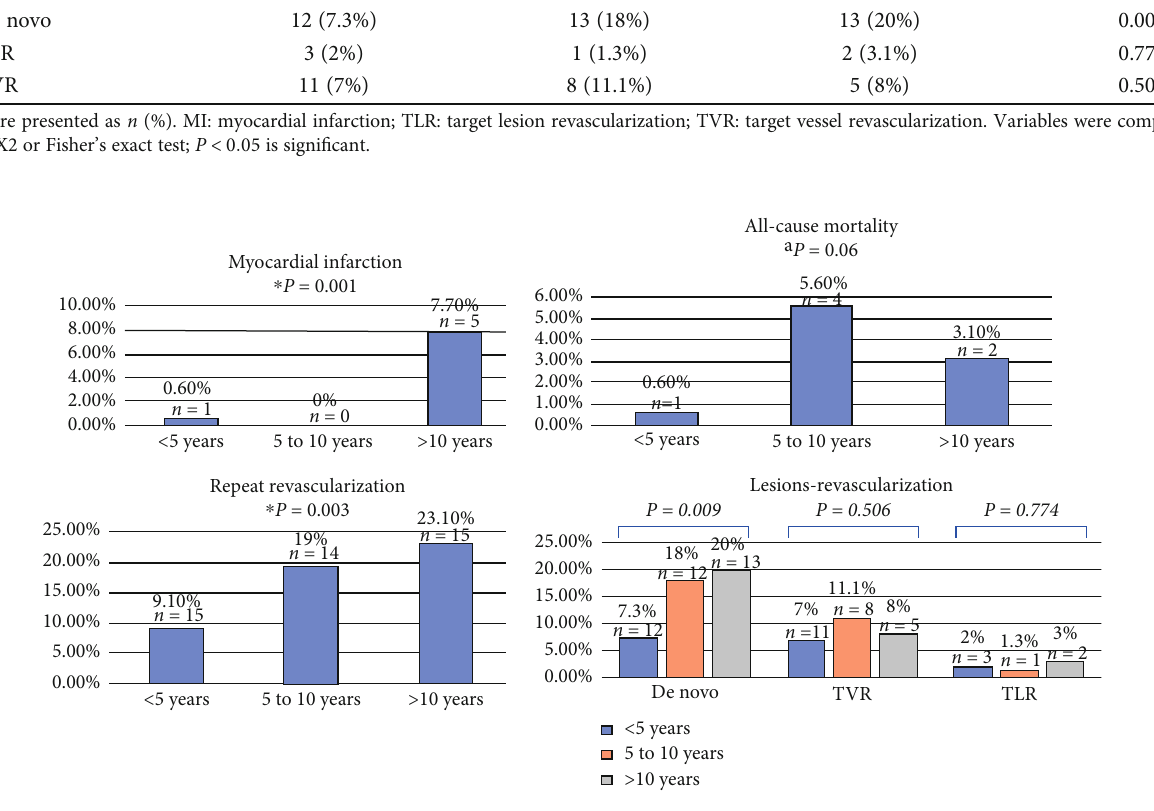
Figure 1: Relationship between diabetes duration and MACEs. Statistical signi fi cance was tested using X2 test for trend; P < 0 : 05 is signi fi cant. ∗ Statistical signi fi cances were tested by ANCOVA with linear trend analysis adjusting confounding cardiovascular risk factors such as age, sex, smoking, systolic blood pressure, and cholesterol. a Statistical signi fi cance was tested using X2 test for trend. TVR: target vessel revascularization; TLR: target lesion